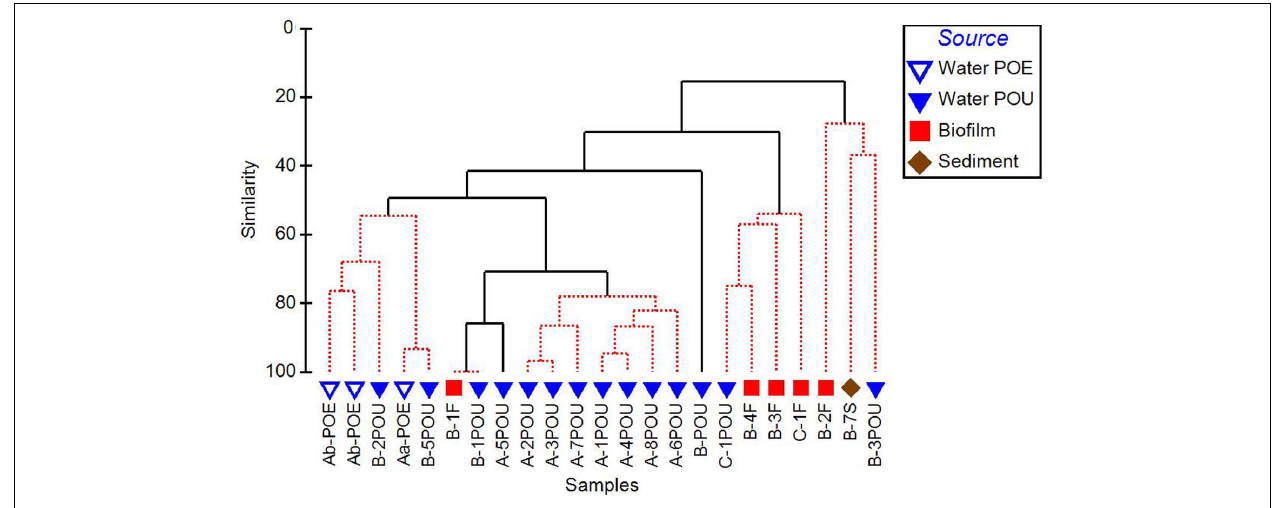
FIGURE 4 | Cluster analysis of 16S rRNA gene normalizedARG copy numbers, considerate of class and relative abundance of eachARG measured in the distribution systems (Aa,Ab, B, C) and across environmental matrices (POE, point of entry water; POU, point of use water; F, biofilm; S, soil). Solid branches indicate significantly different clusters ( p < 0.05).